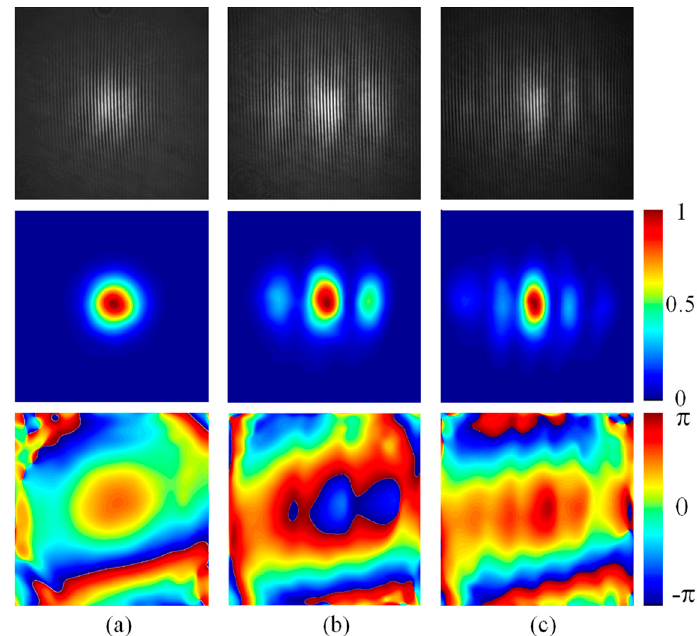
Figure 5. The captured interferogram, reconstructed intensity (a.u.), and wrapped phase maps of Hermite-Gaussian-like modes in ( a ) TELM 00 ; ( b ) TELM 20 and ( c ) TELM 40 . Interferogram (up row), reconstructed intensity profile (middle row), and the reconstructed phase (low row) of the test beams.